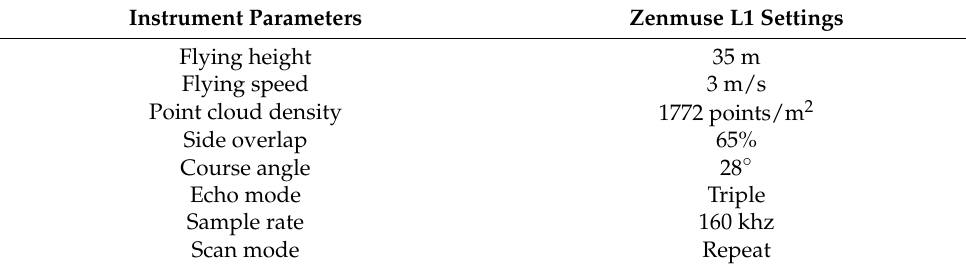
Figure 2. The side view of collected point cloud file with no color. Table 1. ULS parameter